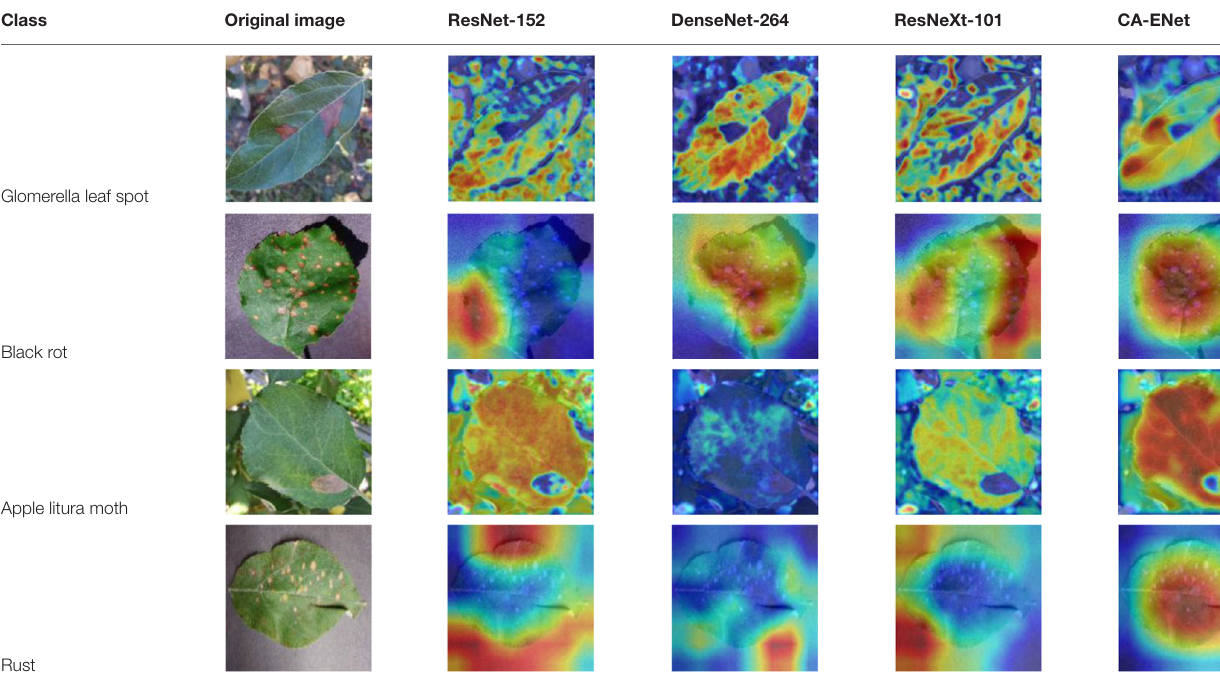
TABLE 5 | Comparison of attention heatmaps of different